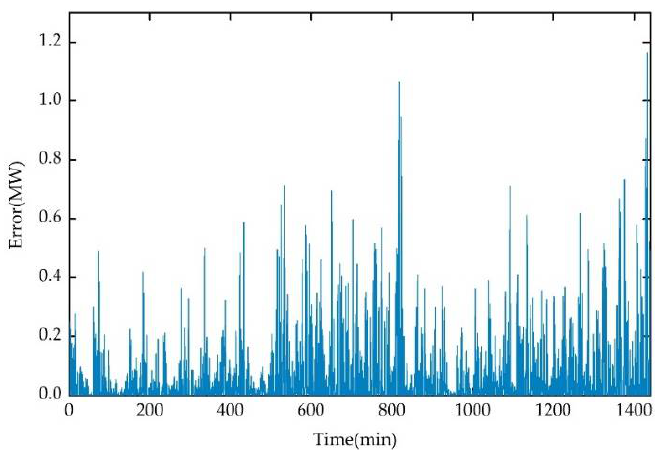
Figure 11. Distribution of the error value.